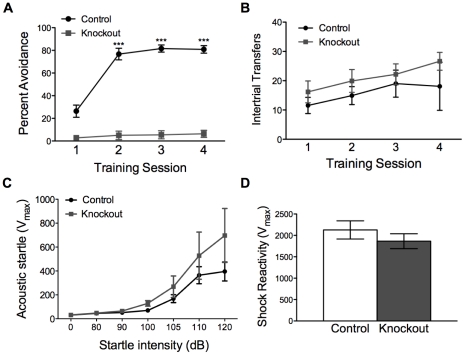
Knockout mice fail to learn two-way active avoidance.(A) Percent shock avoidance by control (n = 11) and knockout (n = 11) animals across training sessions; two-way, repeated-measures ANOVA: genotype effect, F(1, 3) = 165.6, P<0.001; time effect F(3, 60) = 97.0, P<0.001; genotype x time effect F(3, 60) = 76.4, P<0.001 (###P<0.001); ***P<0.001 compared to block 1 within genotype. (B) Intertrial transfers by control (n = 11) and knockout (n = 11) mice during two-way active avoidance sessions; two-way, repeated-measures ANOVA: genotype effect F(1, 20) = 1.18, P = 0.29; day effect F(3, 60) = 2.77, P = 0.05; genotype x day effect F(3, 60) = 0.26, P = 0.86. (C) Acoustic startle response curve for control (n = 8) and knockout (n = 6) mice across startle intensities; two-way, repeated-measures ANOVA; genotype effect F(1, 12) = 1.87, P = 0.20; startle intensity F(6, 72) = 18.03, P<0.001; genotype x startle intensity F(6, 72) = 1.25, P = 0.29. (D) Shock reactivity in control (n = 10) and knockout (n = 5), P = 0.35 by unpaired t test.